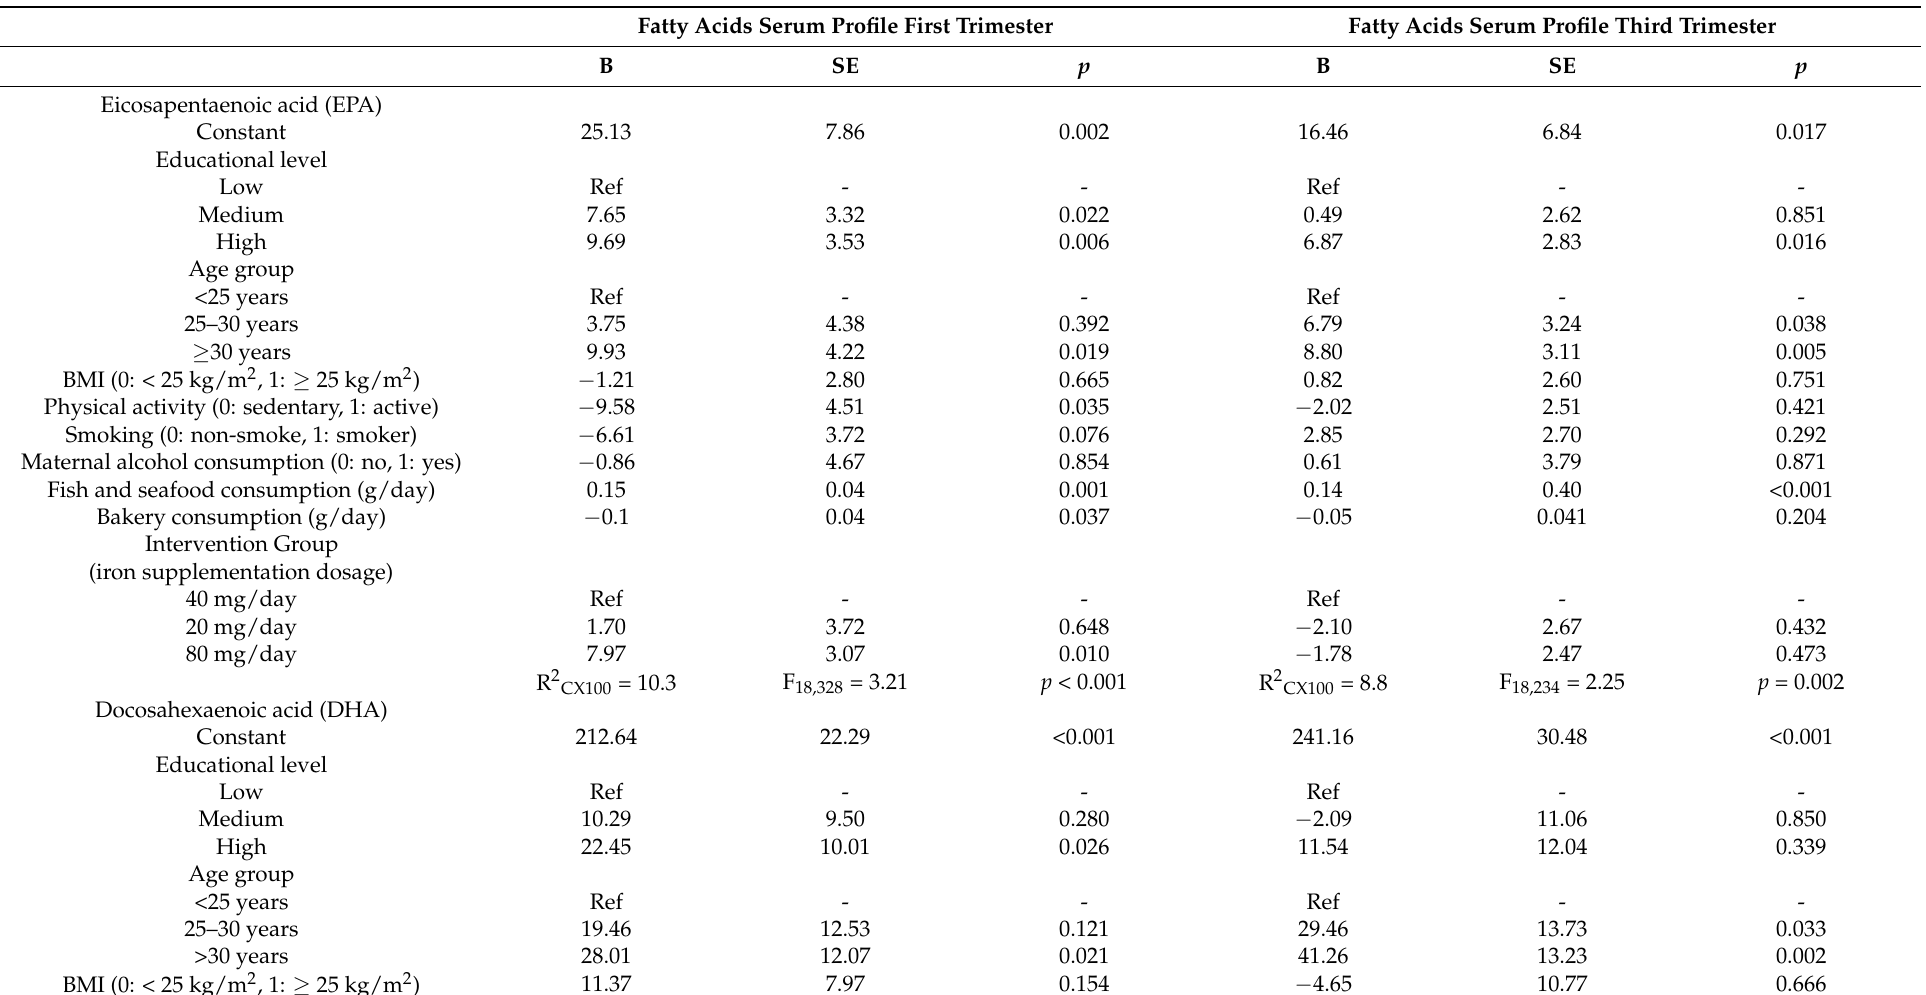
Table 3. Multiple linear regression of potential factors related to maternal serum polyunsaturated fatty acid composition in the first (T1) and third (3T) trimesters of pregnancy. Fatty Acids Serum Profile First Trimester Fatty Acids Serum Profile Third